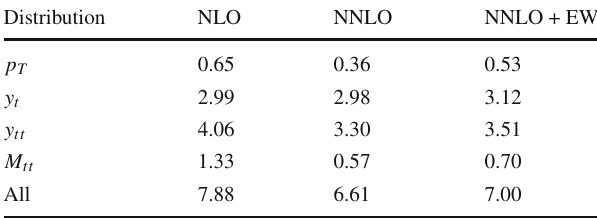
Table 4 χ 2 / N data values for fits to different distributions within the